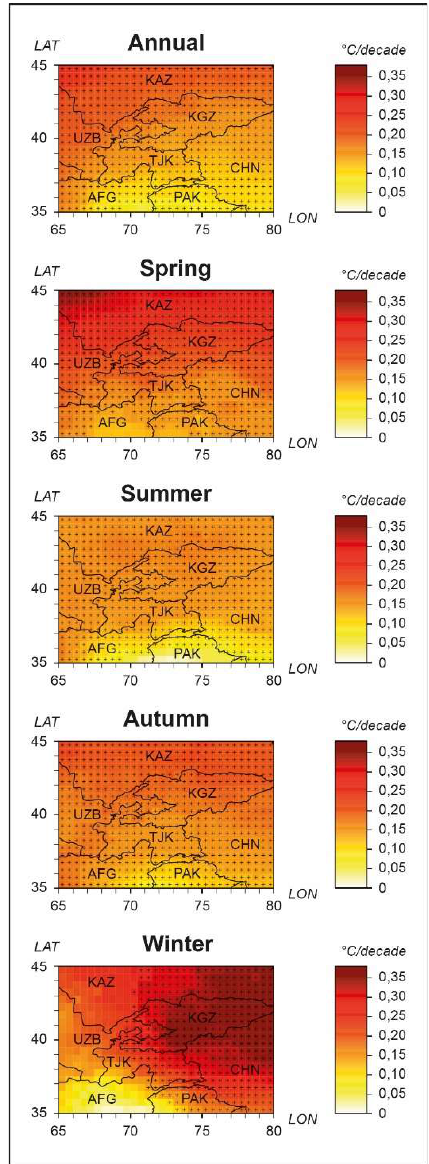
Figure 5. Seasonal and annual temperature trends across the research area for 1950–2016. Statistically significant trends are marked with a plus sign